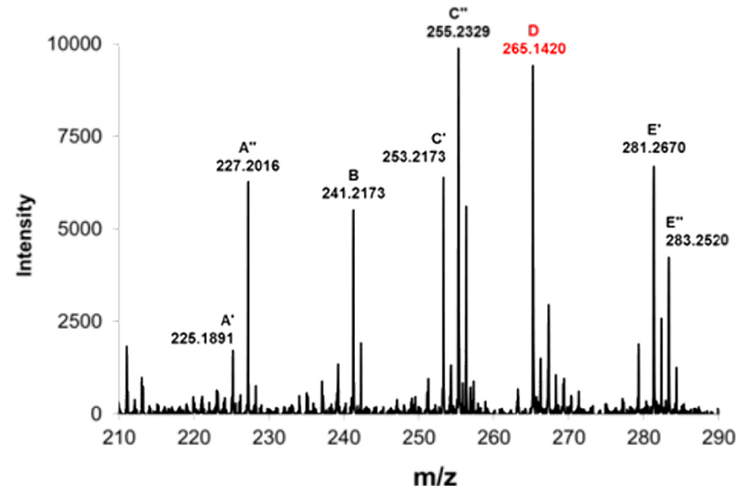
Figure 2. Endogenous compounds in LFMs: both saturated and unsaturated fatty acids (Table 1SI) were identified as [M-H] − deprotonated molecular ions, based on the high resolution spectra. The ion at m / z 265.1420 marked in red is a ubiquitous trace compound on the human skin, SDS, and was used as the instrumental reference.